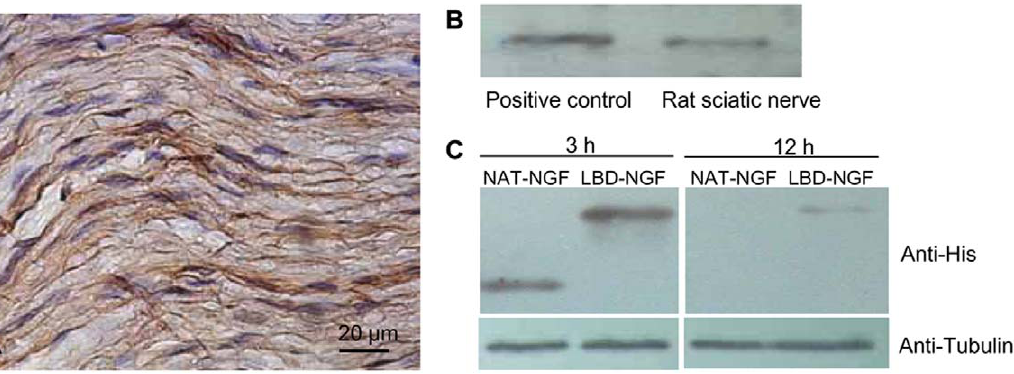
Figure 3. Detection of laminin content and the sustained NAT-NGF and LBD-NGF invivo . (a) Immunohistochemistry of laminin in the rat sciatic nerve. (b) Detection of laminin content in the sciatic nerve by western-blotting analysis. (c) Detection of sustained NAT-NGF and LBD-NGF at the injury sites of sciatic nerves in vivo by western-blotting analysis. (n =6, P , 0.05) (Figure 4E). At week 12 after injury, there were